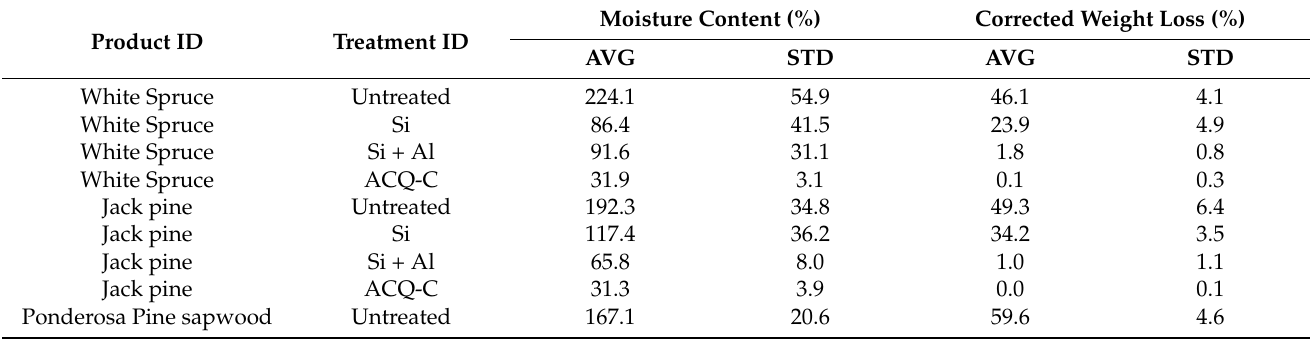
Table 8. Average values and standard deviations for moisture contents and corrected weight losses for test blocks exposed to to Gloeophyllum trabeum after 12 weeks of incubation.